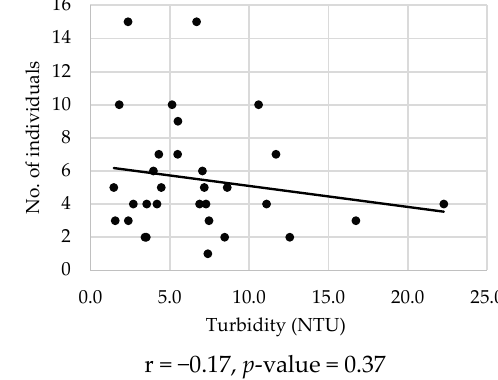
r = 0.11, p -value = 0.53 r = − 0.17, p -value = 0.37 Figure 9. Cont